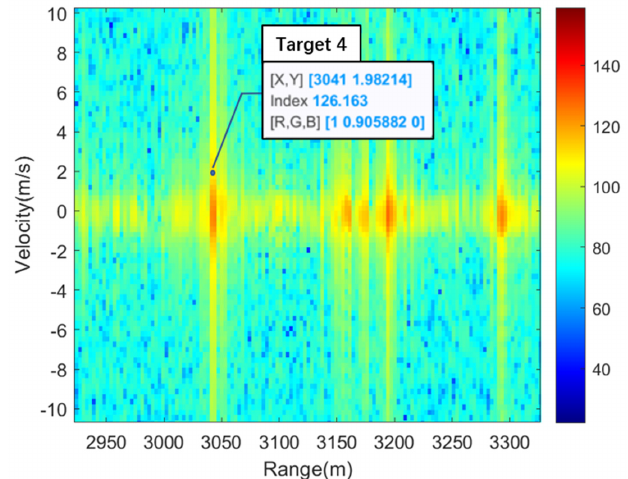
Figure 11. The range − velocity map in Channel 1 for the first field experiment. Target 4 ′ s information is indicated via a data label; the target was submerged in strong ground clutter.